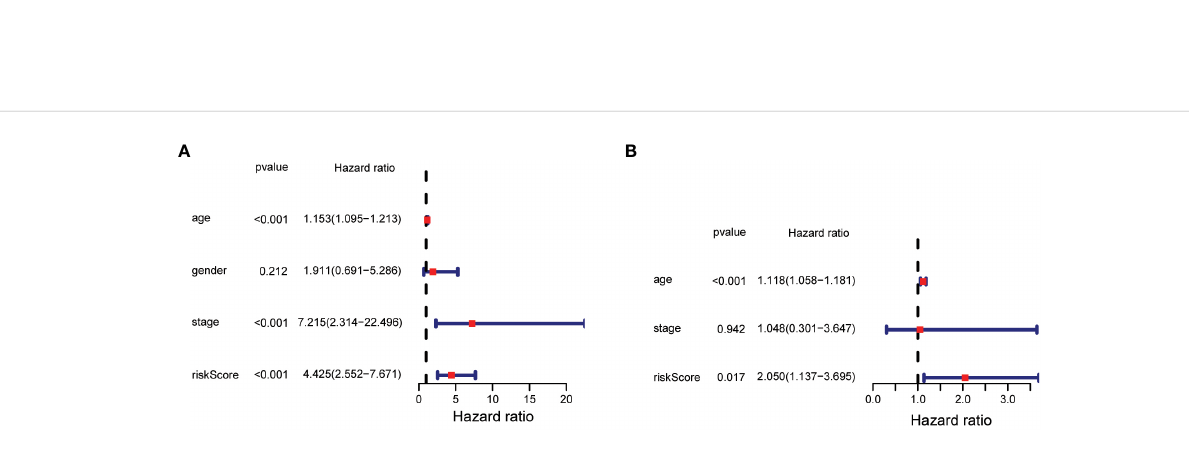
FIGURE 5 Results of univariate and multivariate Cox regression analysis on OS. (A) Univariate Cox regression analysis on OS. (B) Multivariate Cox regression analysis on OS.